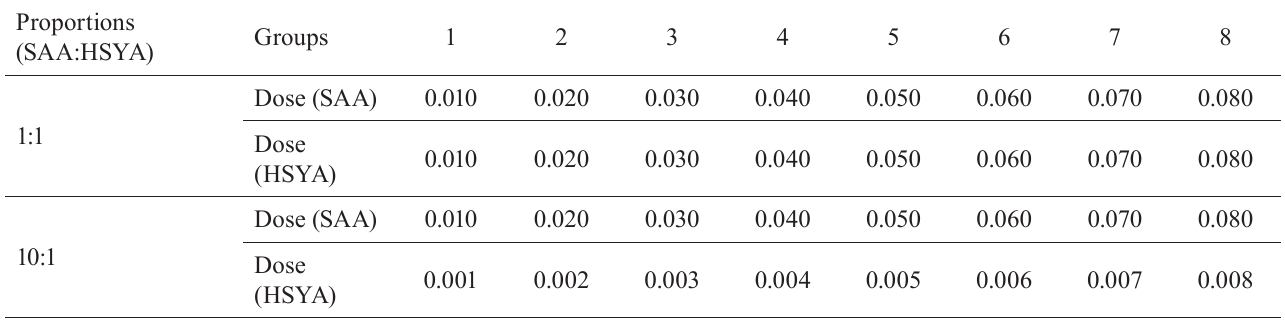
TABLE II - Drug combination concentration of SAA and HSYA in different proportions*